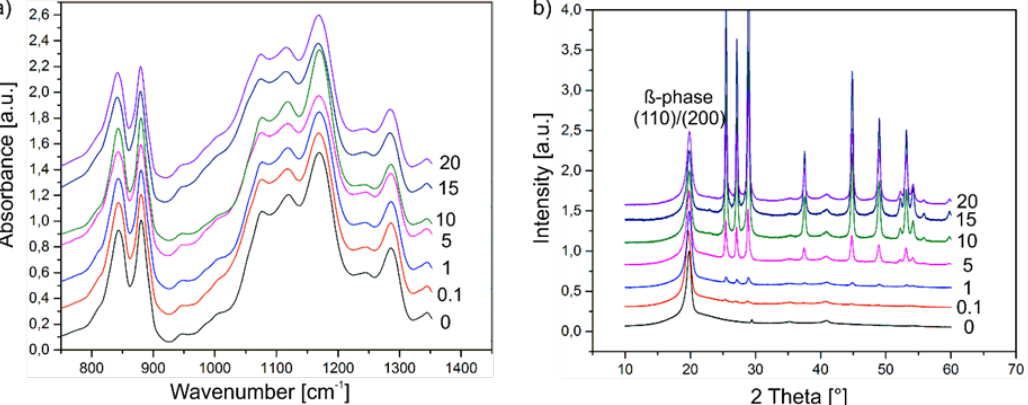
Figure 4. ( a ) Attenuated total reflection Fourier transformed infrared spectroscopy (ATR-FTIR) spectra and ( b ) X-ray diffraction (XRD) spectra of P(VDF-TrFE) composite films with different (Cd:Zn)S particle concentration (0 = 0 vol %, 0.1 = 0.1 vol %, 1 = 1 vol %, 5 = 5 vol %, 10 = 10 vol %, 15 = 15 vol %, 20 = 20 vol %).